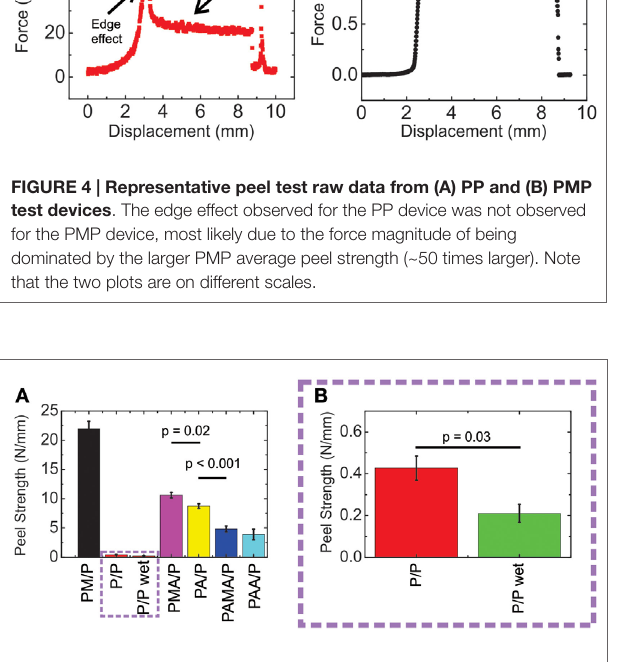
FigUre 5 | (a) Combined average peel test data (mean ± SE, n = 3–8) from various trials. Parylene/Parylene interfaces had the lowest peel strength and were regraphed separately (B) using a different scale. The slash indicates the interface at which delamination occurred.